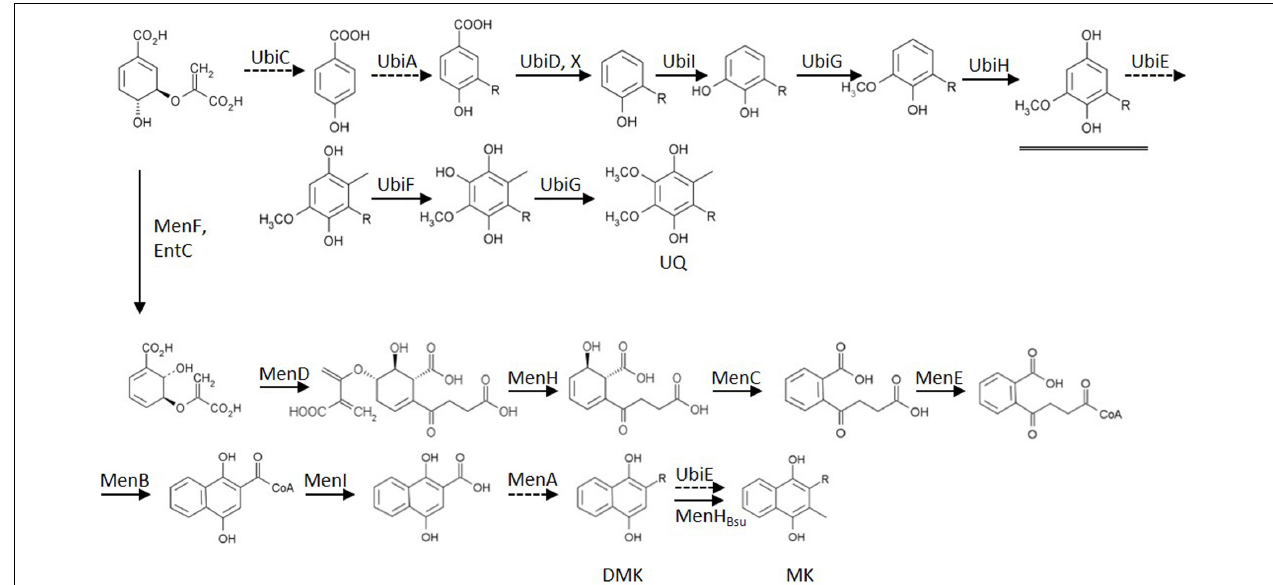
FIGURE 1 | Biosynthesis routes of the quinones of Escherichia coli , starting from chorismate. Dashed arrows indicate enzymes deleted in mutants used in this study. The double arrow symbolizes the action of the introduced heterologous MenHBsu. The underlined intermediate C1-demethyl-C6-demethoxy-Q8 (DDMQ8) may accumulate in a ubiE mutant strain (for references: see text). Established bio-active quinones are indicated via their abbreviation. UQ, ubiquinone; DMK, demethylmenaquinone; MK, menaquinone; R, isoprenoid